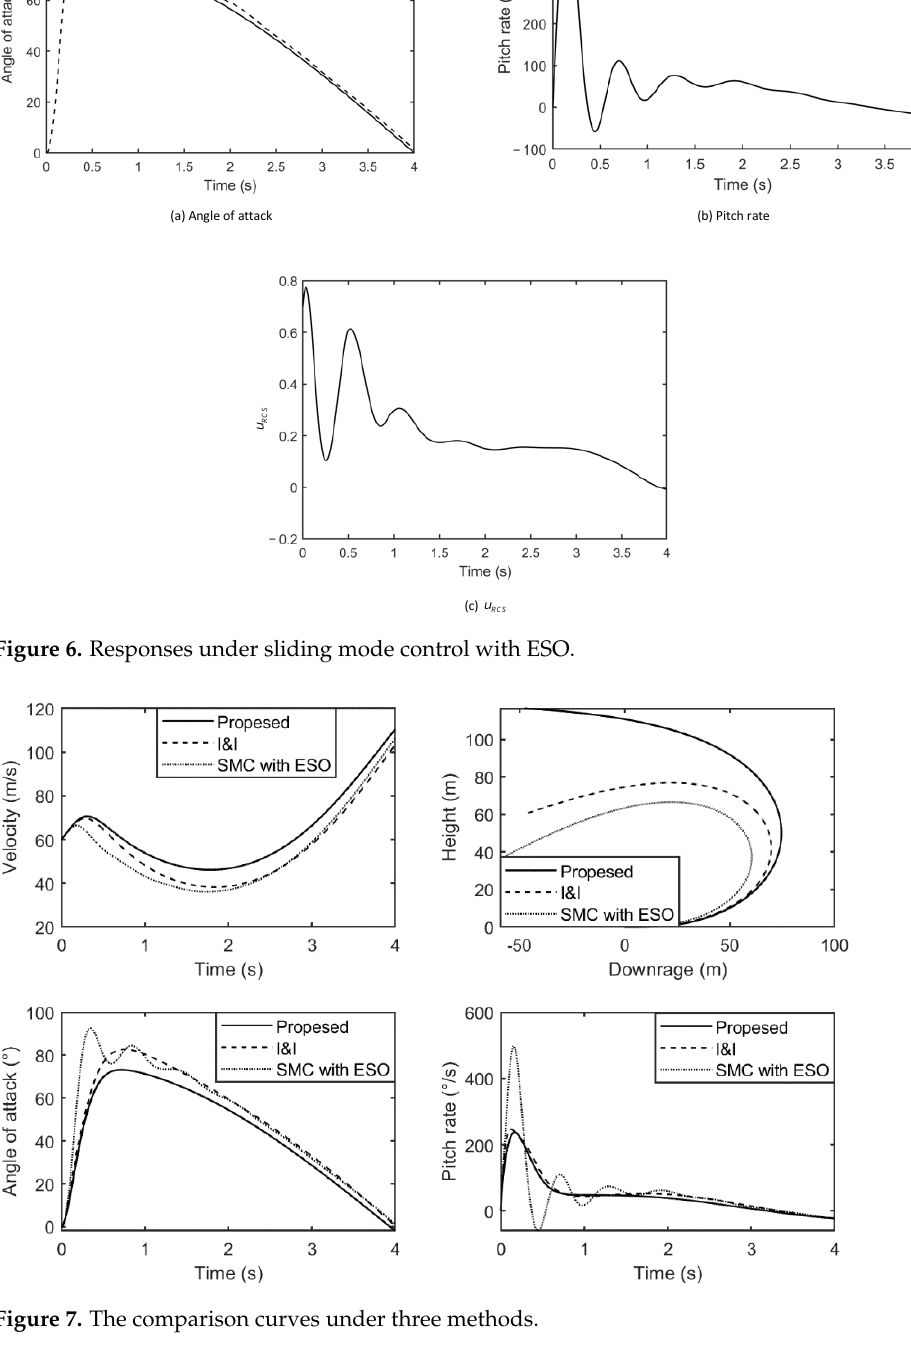
Figure 7. The comparison curves under three methods.